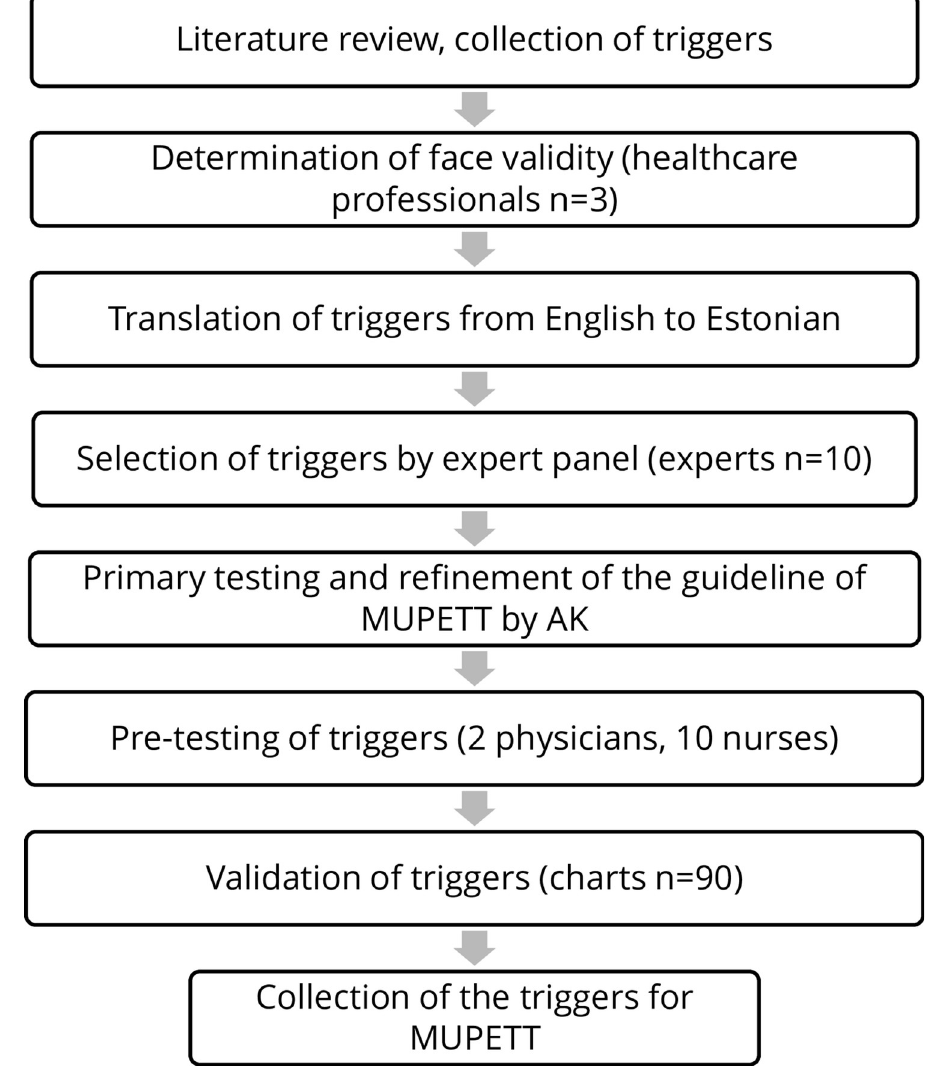
Fig 1. Overview of development of an Estonian trigger tool to evaluate adverse events in multimorbid patients. MUPETT—MUltimorbid Patients—Estonian Trigger Tool. AK—Angela